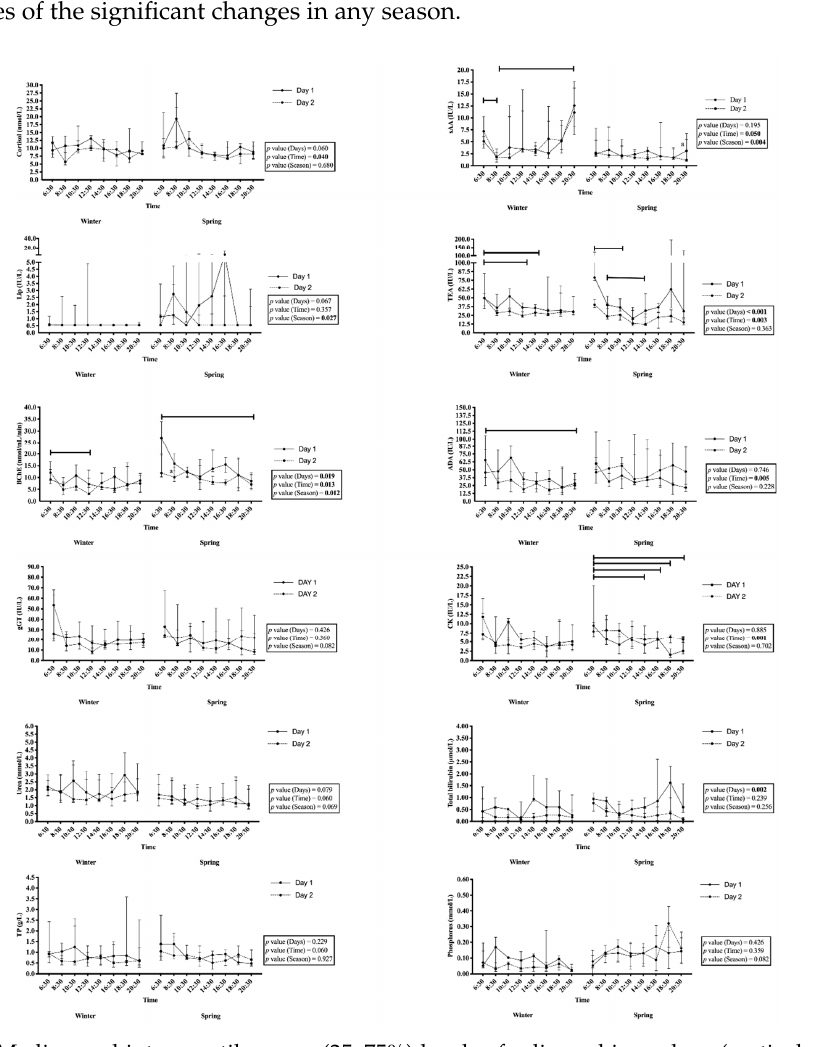
Figure 2. Median and interquartile range (25–75%) levels of salivary biomarkers (cortisol, salivary alpha-amylase (sAA), lipase (Lip), total esterase (TEA), butyrylcholinesterase (BChE), adenosine deaminase (ADA), γ‐ glutamyl transferase (gGT), creatine kinase (CK), urea, total bilirubin, total protein (TP), and phosphorus) measured for two consecutive days in two different seasons (16–17 December 2019 (winter), or 19–20 May 2020 (spring)) in five mares in Murcia, Spain. Significant changes in the within ‐ subject factors of ‘Day’, ‘Time’, and ‘Season’ were detected using a three ‐ way ANOVA of repeated measures, and significant changes were analyzed between the hours of the day in the same season (lines) or between seasons (letters) by a Fisher’s least significant difference (LSD) test when occurring on both day 1 and day 2. The bold p values indicate significance levels lower than 0.05.